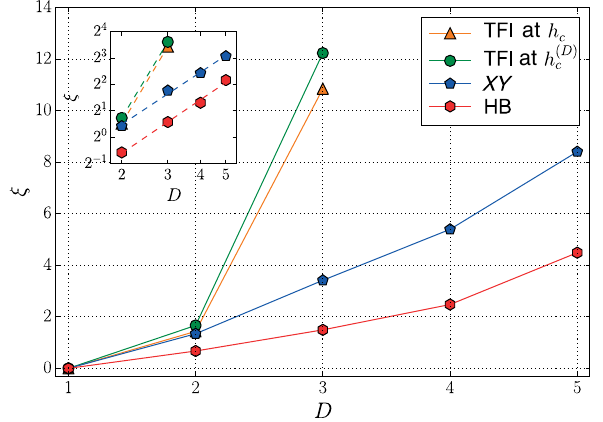
FIG. 8. Overview of the finite- D iPEPS correlation lengths ξ observed in the critical transverse-field Ising model (TFI) and the continuous symmetry-breaking XY and Heisenberg models. The inset displays the same data on logarithmic scales.